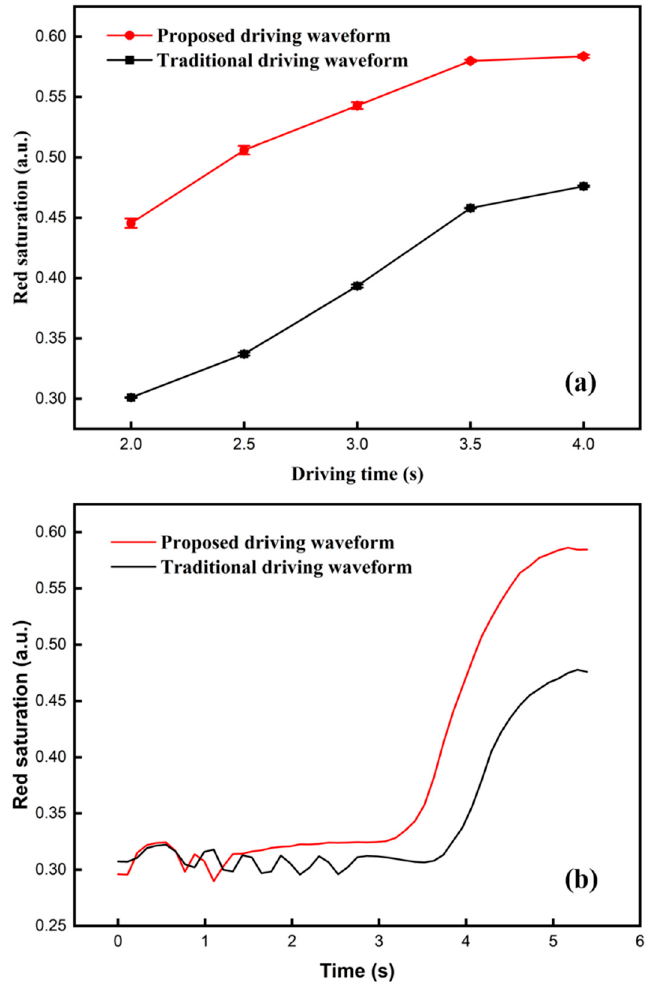
Figure 5. The red saturation of the three-color EPD with different driving schemes. ( a ) The relationship between the red saturation and different driving times of the red driving stage. ( b ) Red saturation curves of the traditional and the proposed driving scheme when the driving time was 4 s. The maximum value of red saturation was 0.58, which was 0.11 higher than that of the traditional driving scheme.